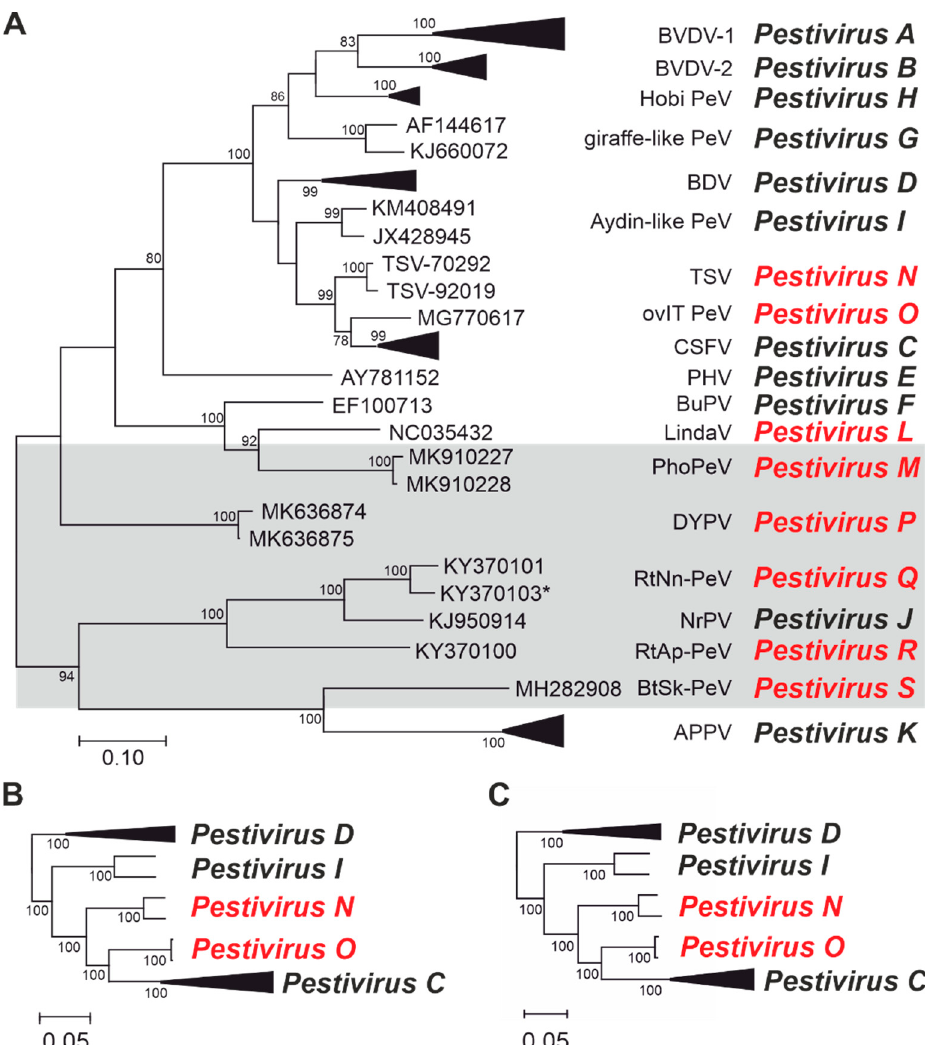
Figure 1. Phylogenetic characterization of known pestiviruses. ( A ) Construction of the Maximum likelihood tree was based on the conserved partial NS5B peptide sequences corresponding to positions 3312–3837 in the polyprotein of BVDV-1 ( Pestivirus A) reference strain SD-1. With one exception (KY370103, indicated by asterisk), the sequences were derived from complete coding sequences. Core data set was used as established earlier and modified as described in Materials and methods [26]. Given are GenBank accession numbers and abbreviations of virus names as listed in Tables 1 and 3. The established ( Pestivirus A through Pestivirus K ; black) and newly proposed ( Pestivirus L through Pestivirus S ; red) pestivirus species are indicated next to the tree. Pestivirus sequences identified in non-ungulate hosts are highlighted (grey shaded box). For clarity, the clades for viruses in the species Pestivirus A , Pestivirus B , Pestivirus C , Pestivirus D , Pestivirus H, and Pestivirus K are collapsed. For statistical analysis, 1000 bootstrap repetitions were performed. Only bootstrap values >70% are shown. A subset of pestivirus species closely related to TSV ( Pestivirus N ) and ovIT PeV ( Pestivirus O ) was analyzed separately by Maximum likelihood analyses for complete coding sequences ( B ) and polyprotein sequences ( C ) to compare the topologies of the trees. Table 3. Recently reported pestivirus sequences.